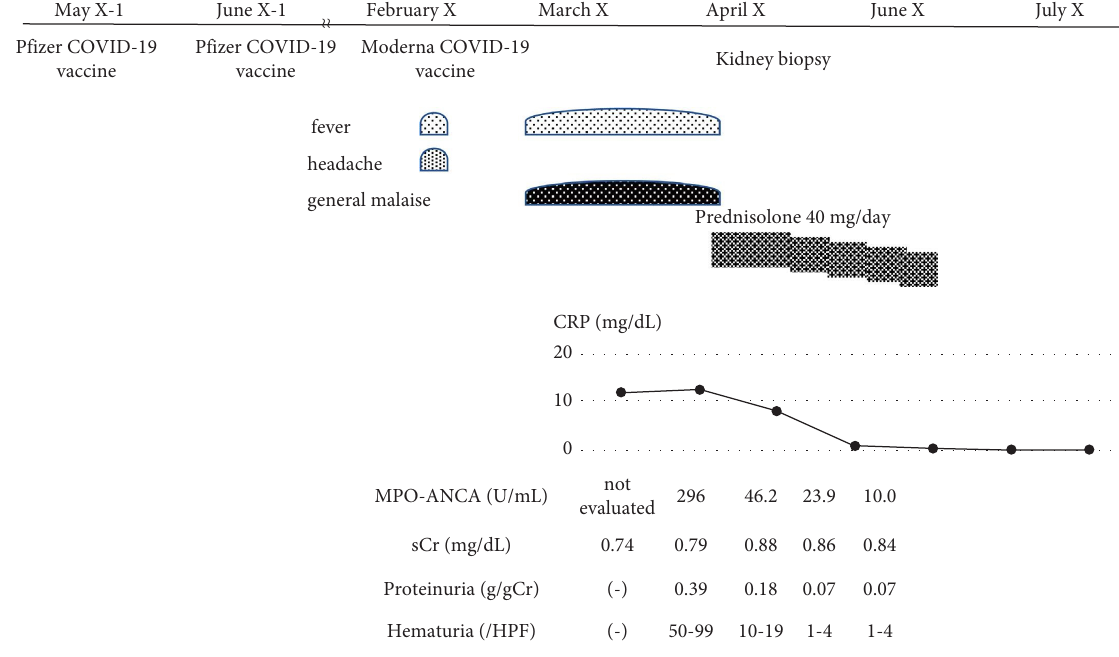
Figure 3: Clinical